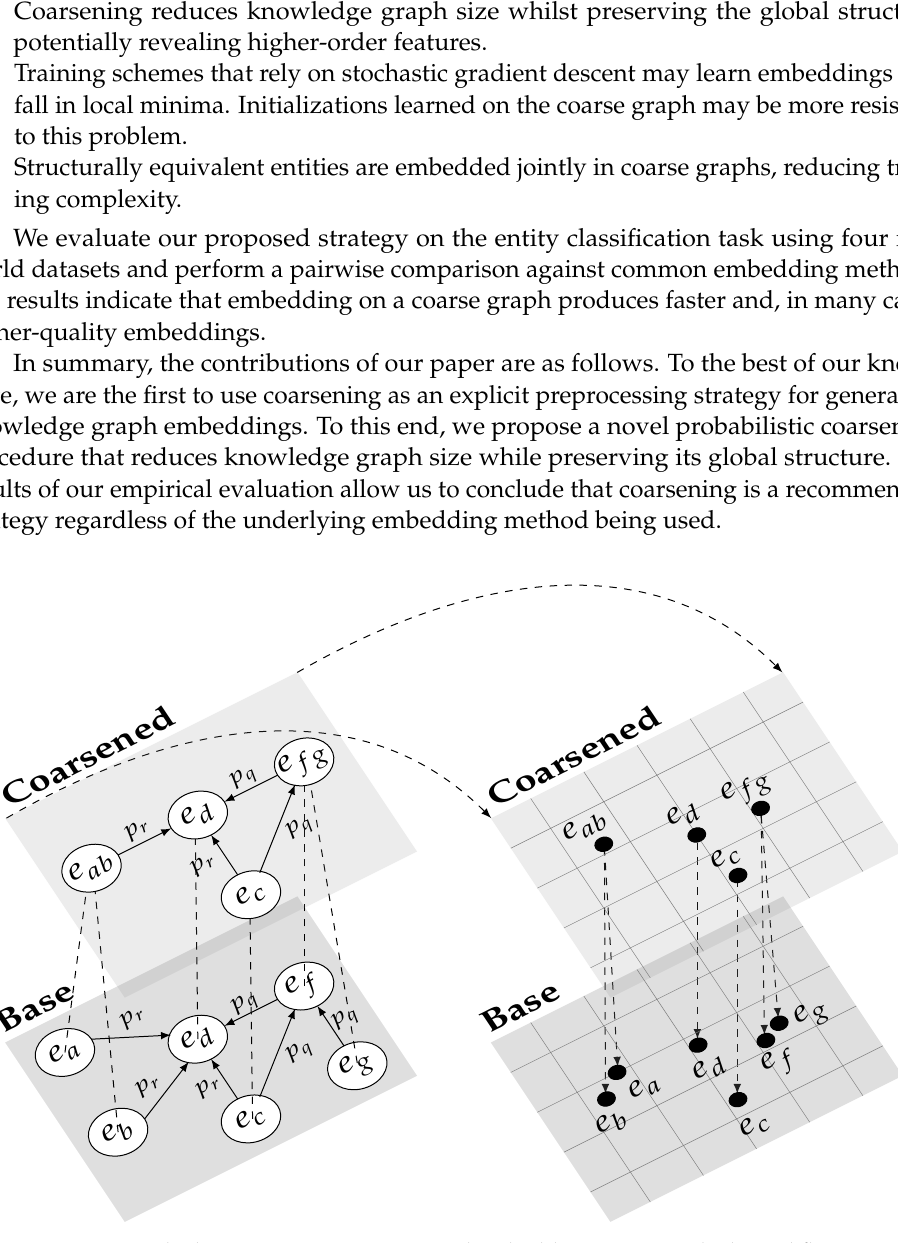
Figure 1. Toy example demonstrating our proposed embedding strategy. The logical flow is guided by dashed line arrows, starting in the bottom left corner and proceeding